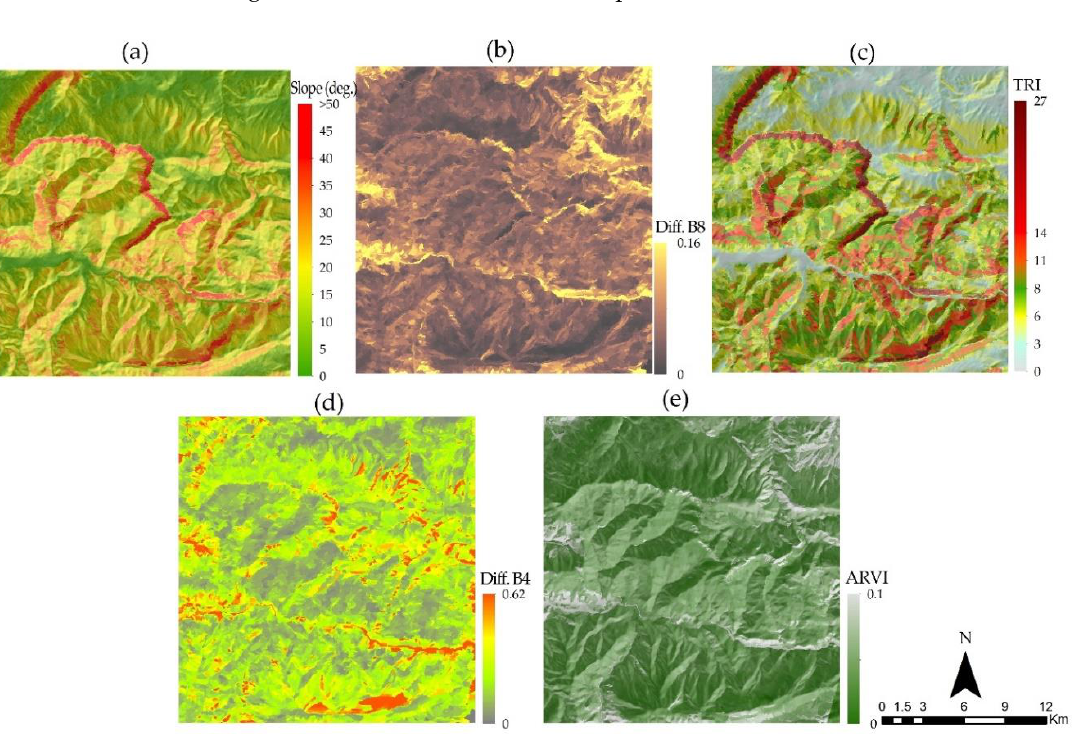
Figure 7. The spatial variations of the top five important variables in the mapping of historical landslides in the protected forests, NE Iran; the mean slope ( a ), the mean difference to neighbors of the narrow-near-infrared band (B8A; Sentinel-2A) ( b ), the mean values of TRI ( c ), the mean difference to neighbors of the red band (B4; Sentinel-2A) ( d ), and the standard deviation values of the atmospherically resistant vegetation index (ARVI) ( e ).